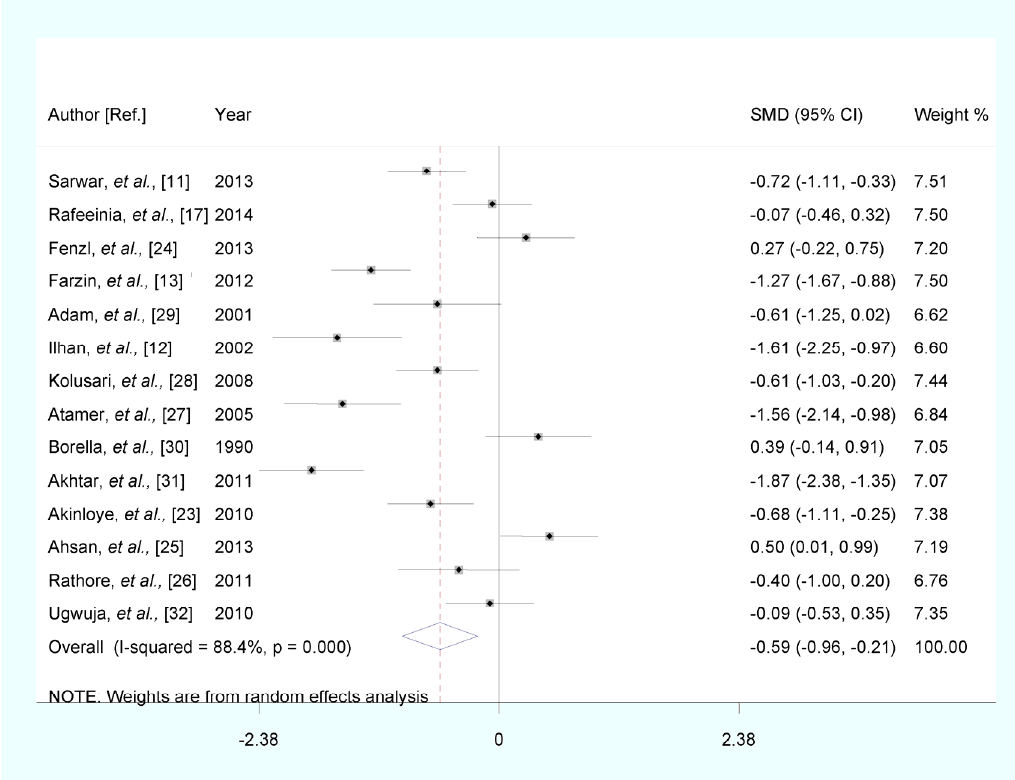
Figure 2. Forest plot of standard mean difference (SMD) with corresponding 95% confidence interval (CI) of studies on zinc levels in total preeclampsia (PE) and healthy pregnancy controls. The size of grey box is positively proportional to the weight assigned to each study, and horizontal lines represent the 95% CIs.